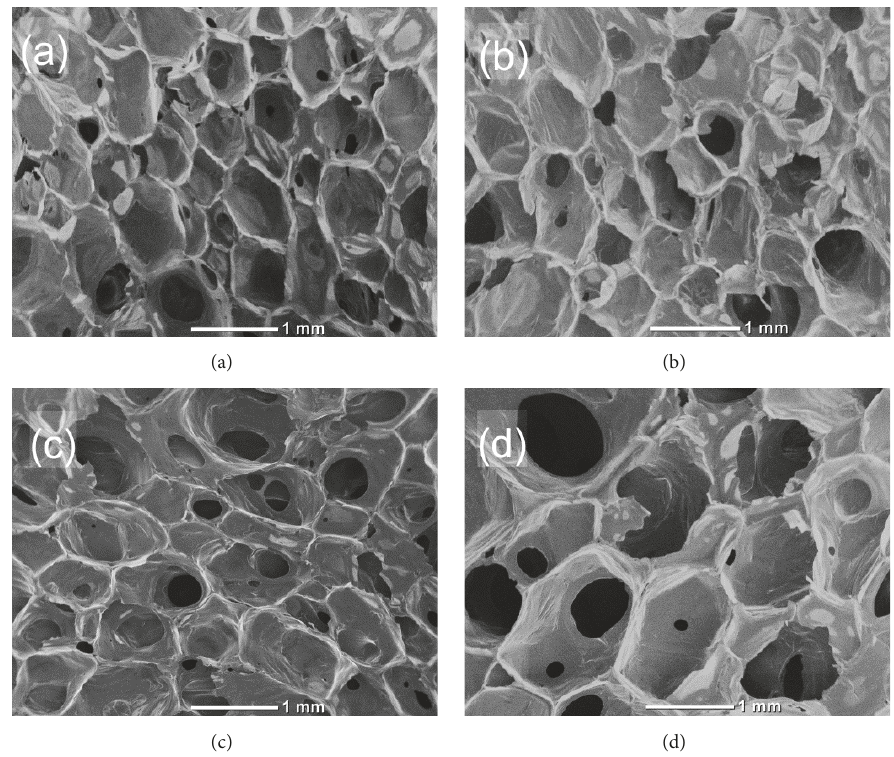
Figure 1: SEM images of (a) pure polyol, (b) 5% lignin, (c) 10% lignin, and (d) 15% lignin content polyurethane foams.